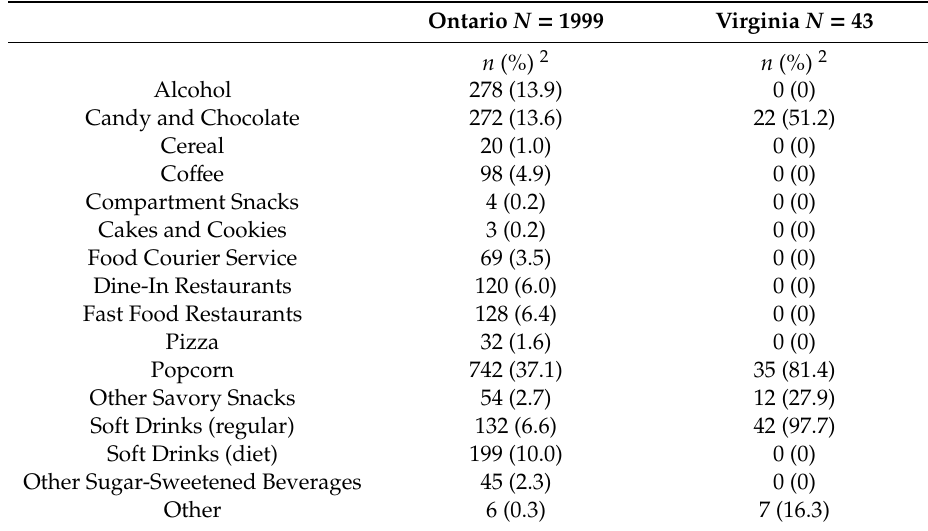
Table 1. Frequency of advertisements by food category in the movie theatre environment in Ontario and Virginia from February to May 2019 1 .